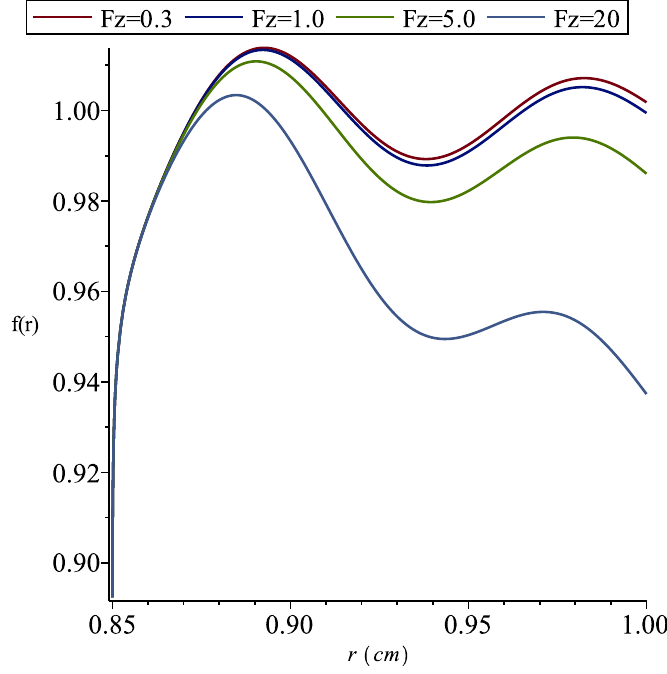
Figure 3. f versus r for α = − 5000 in level set function φ , R i = 0.85 cm is the radial value at the gas/liquid interface.